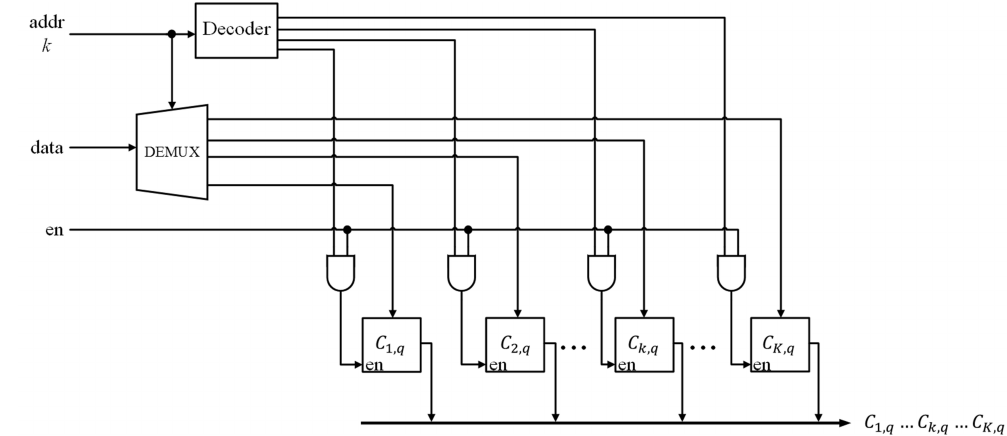
Figure 8. The block diagram of each module of the memory unit. It consists of K cells, where each cell stores a center associated with its dedicated channel.